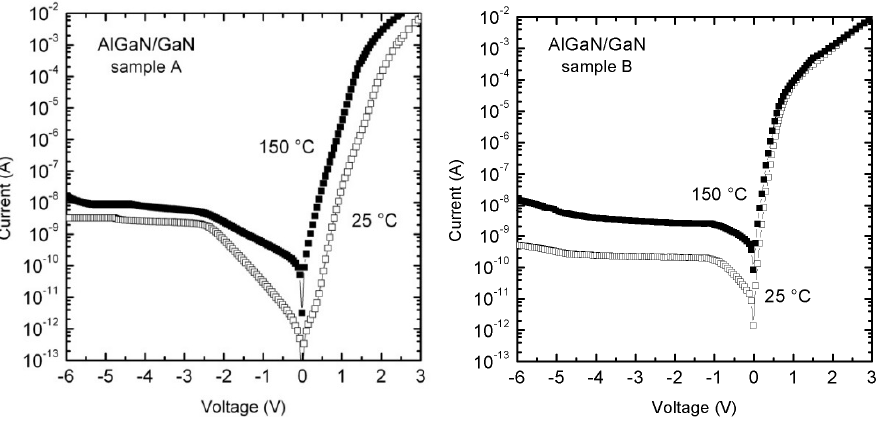
Figure 2. Typical I – V characteristics for SD structures A and B measured at 25 °C and 150 °C.